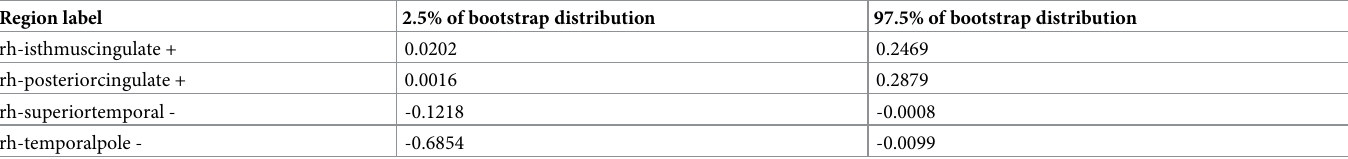
Table 3. Listing of the 4 regions that were identified with robust loadings in the bootstrap estimation procedure. Region label